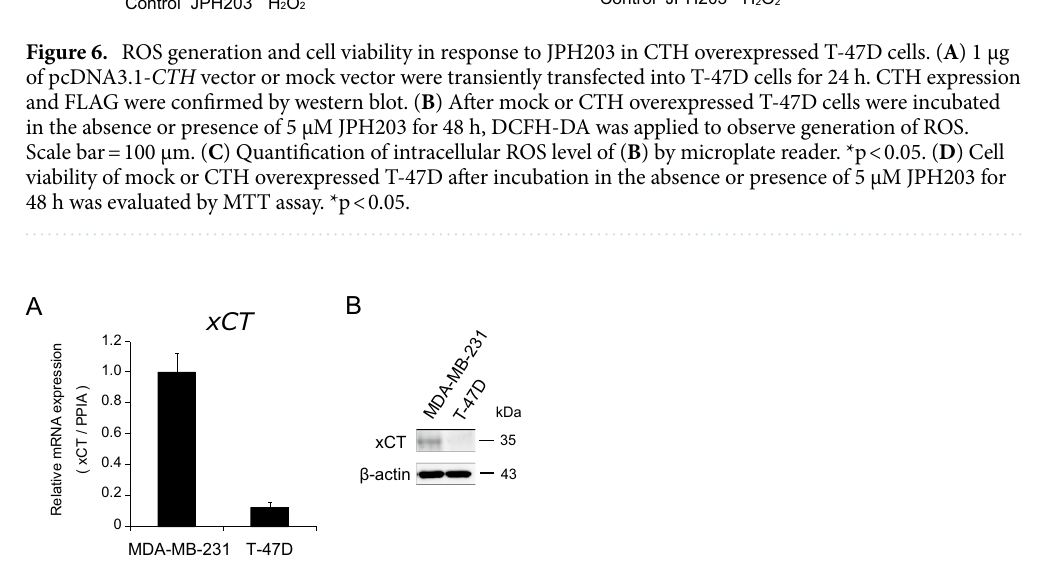
Figure 7. xCT expression in MDA-MB-231 and T-47D cells. ( A ) Non-stimulated basal xCT mRNA expression in MDA-MB-231 and T-47D cells by qPCR. ( B ) Non-stimulated basal xCT protein expression in MDA-MB-231 and T-47D cells by western blot